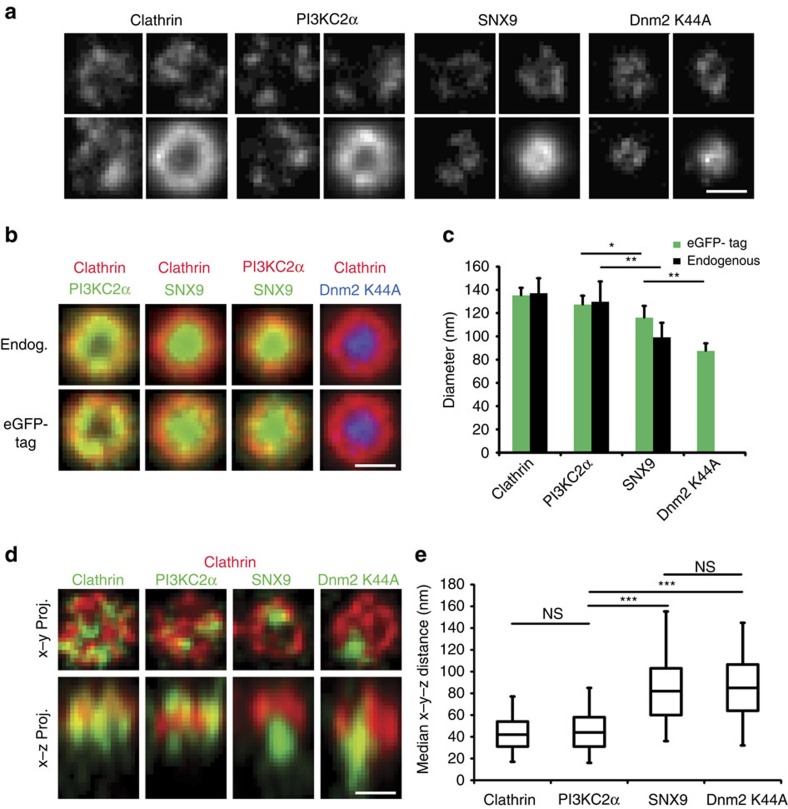
SNX9 nanoscale localization to the neck of late stage CCPs.(a) dSTORM images of endogenous clathrin, PI3KC2α and SNX9 or Dnm2-eGFP at late stage Ω-CCP in Cos7 cells expressing GTPase-deficient dynamin 2 (Dnm2) K44A-eGFP. Centre-aligned average images (bottom right quarters) were generated from 180–762 CCP from three to nine cells. (b) Overlay of centre-aligned averaged dSTORM images. (c) Quantification of diameter of averaged structures from endogenous and eGFP-tagged proteins. Data represent mean±s.d. (n=180–763 CCPs from three to nine cells) (d) 3D-dSTORM images of eGFP-tagged clathrin, PI3KC2α, SNX9 and Dnm2 K44A together with endogenous clathrin in Dnm2-K44A expressing Cos. Shown are representative x–y projections and x–z projections from 200 × 200 × 1,200 nm volumes centred around individual CCPs (e) Quantification of the distance of the median from clathrin towards the indicated markers (Clathrin: 647 CCPs from nine cells from three experiments, PI3KC2α: 746 CCP from 10 cells from three experiments, SNX9: 725 CCP from 12 cells from five experiments, Dnm2-K44A: 488 CCPs from 13cells from five experiments). Statistical test on c,e was performed with Student’s t-test; NS, non-significant, ***P<0.001, **P<0.01 and *P<0.05, Scale bars, 100 nm.